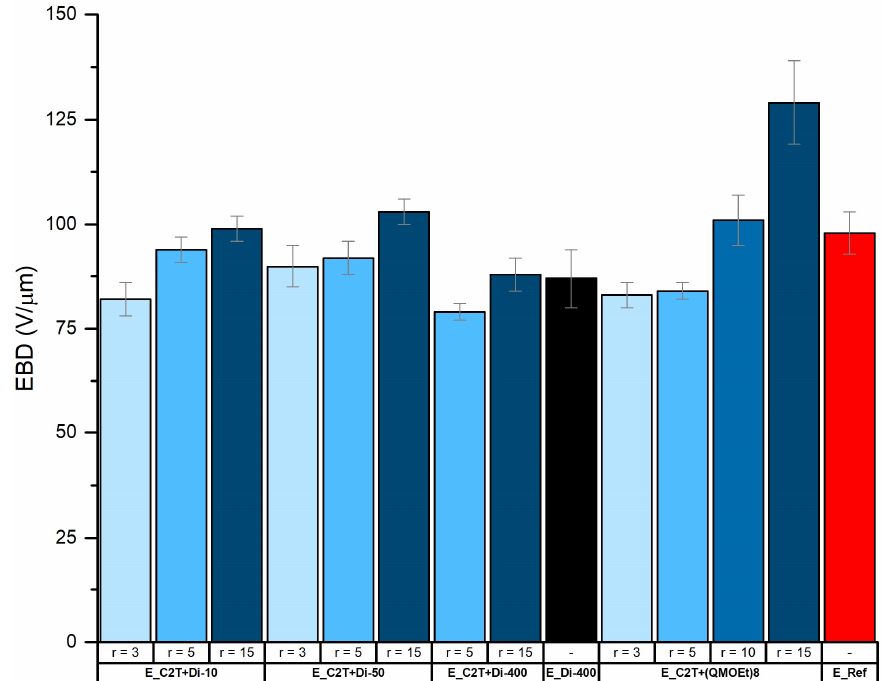
Figure 11. Electrical breakdown (EBD) strength (V/µm) of commercial coating E_Ref and elastomer films prepared via the reaction between C2T and Di-10, Di-50, Di-200, and (QM OEt ) 8 , respectively. Film thickness was ~100 µm.